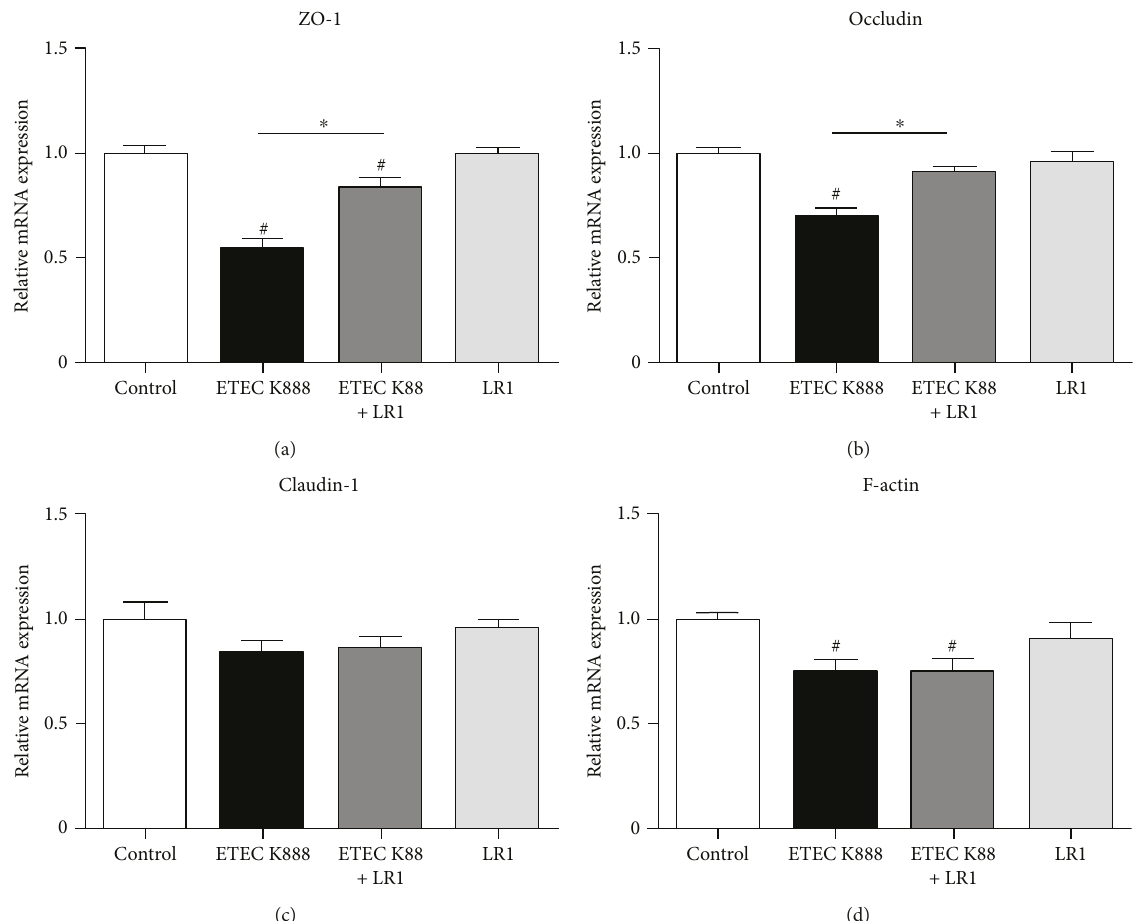
Figure 2: The mRNA levels of components of epithelial barrier in IPEC-1 cells. Relative transcript levels of ZO-1 (a), occludin (b), claudin -1 (c), and F-actin (d) in IPEC-1 cells were determined by qPCR. GAPDH and β -actin were used as housekeeping genes, and the 2 – ΔΔ Ct method was used to determine the relative abundance. Data were further normalized to values measured in control treatments. All data are expressed as the mean ± SEM ( n = 6 ) and representative of 3 independent experiments. Di ff erences were determined by one-way ANOVA. # P < 0 05 compared with control, ∗ P < 0 05